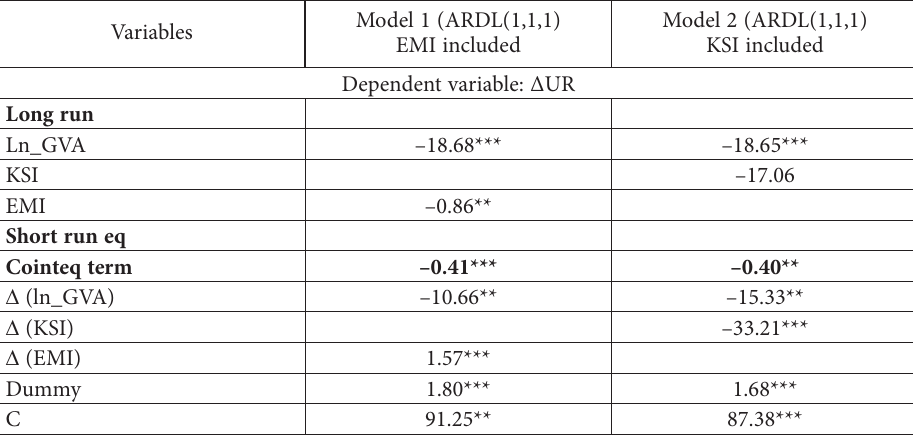
Table 4. Panel Data Analysis results for Manufacturing